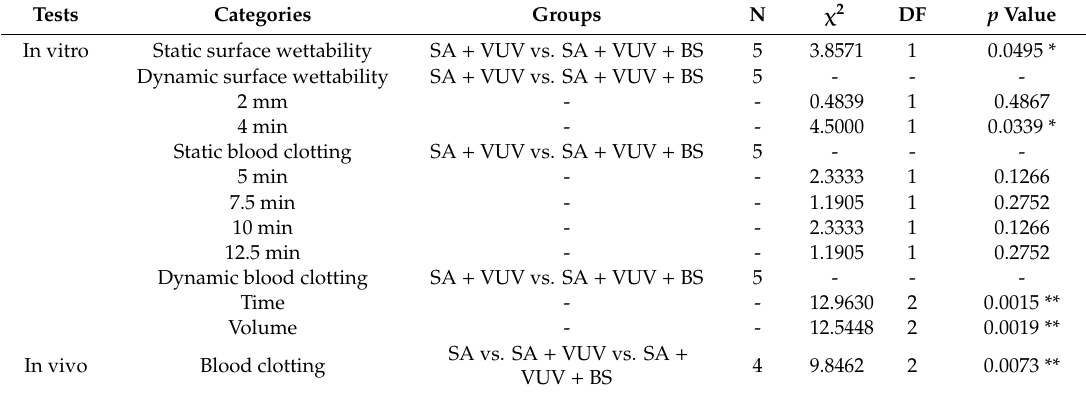
Table 1. Summary Statistics of this